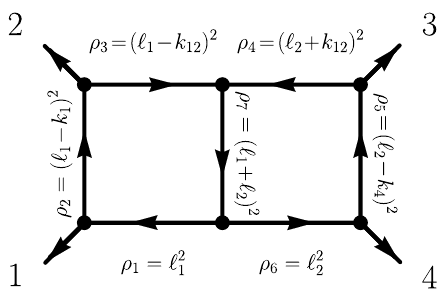
Figure 2 . The double-box